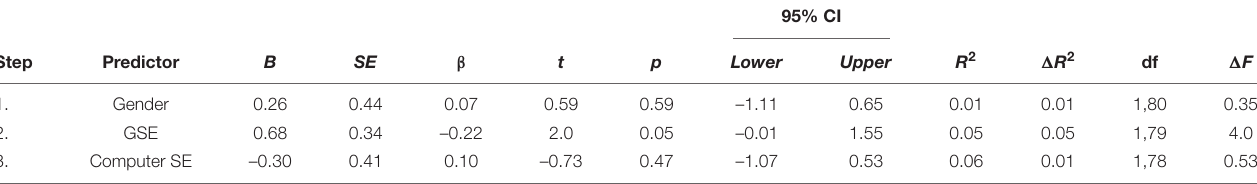
TABLE 5 | Summary of hierarchical regression for increased computer typing following commencement of the COVID-19 pandemic.